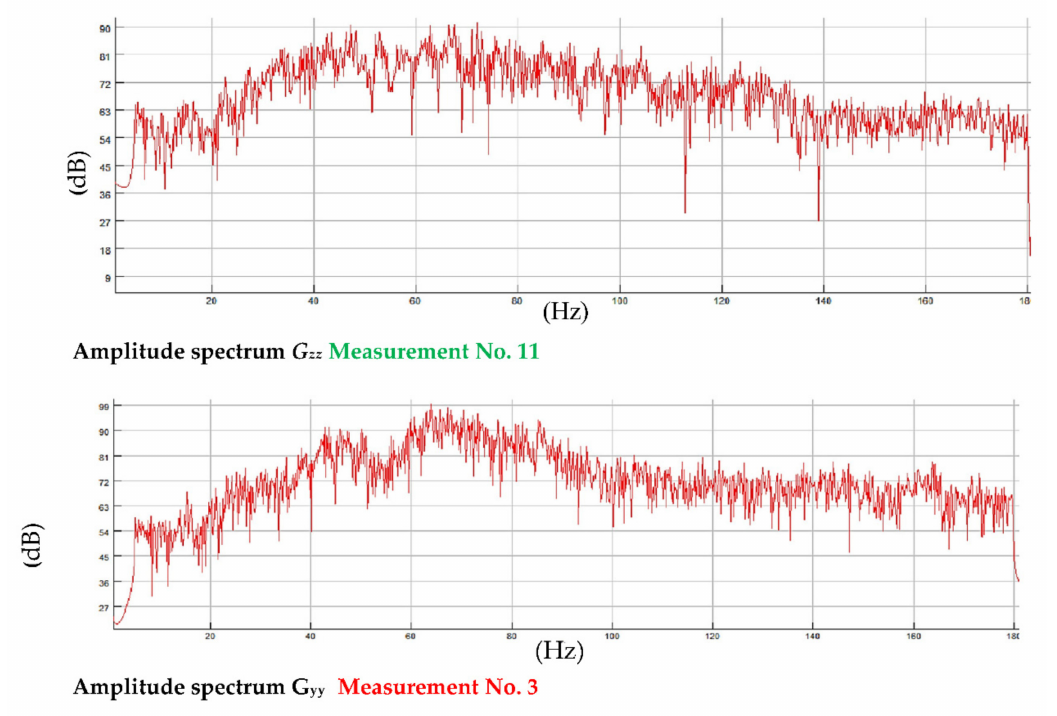
Figure 12. Amplitude spectrum of Gzz (measurement no. 1) and G yy (measurement no. 3) in logarithmic scale from vibration velocity recording.